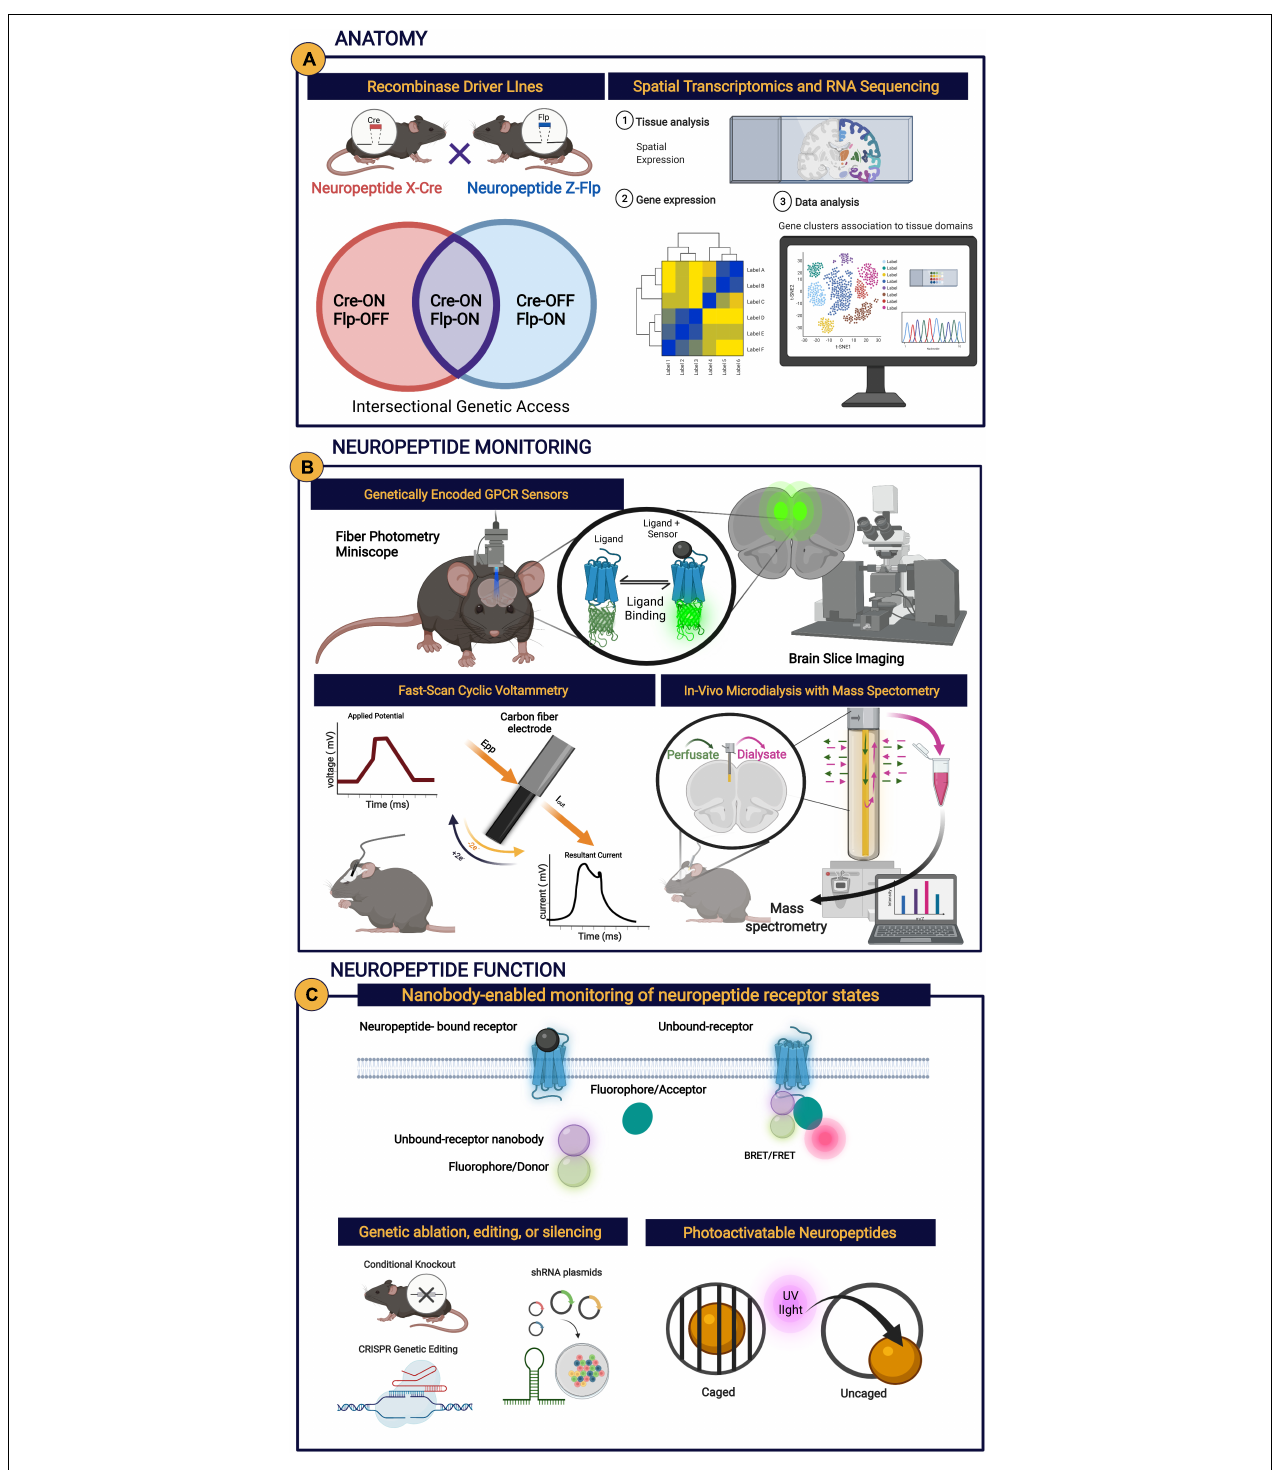
FIGURE 2 | (A) Anatomical methods in the study of neuropeptides include recombinase driver lines used to gain genetic access to neuropeptide or receptor-expressing cells, spatial transcriptomics, and RNA sequencing. (B) Neuropeptide monitoring methods include genetically encoded GPCR sensors in conjunction with recording methods (e.g., fiber photometry and miniscope), fast-scan cyclic voltammetry (inspired by Roberts and Sombers, 2018), and in vivo microdialysis with mass spectrometry. (C) Methods to study neuropeptide function include nanobody enabled monitoring of neuropeptide receptor states (inspired by Che et al., 2020), genetic modifications (e.g., genetic ablation, editing, or slicing), and the use of photoactivatable neuropeptides. Any of the aforementioned novel approaches can be implemented with established methodologies, such as electrophysiology.